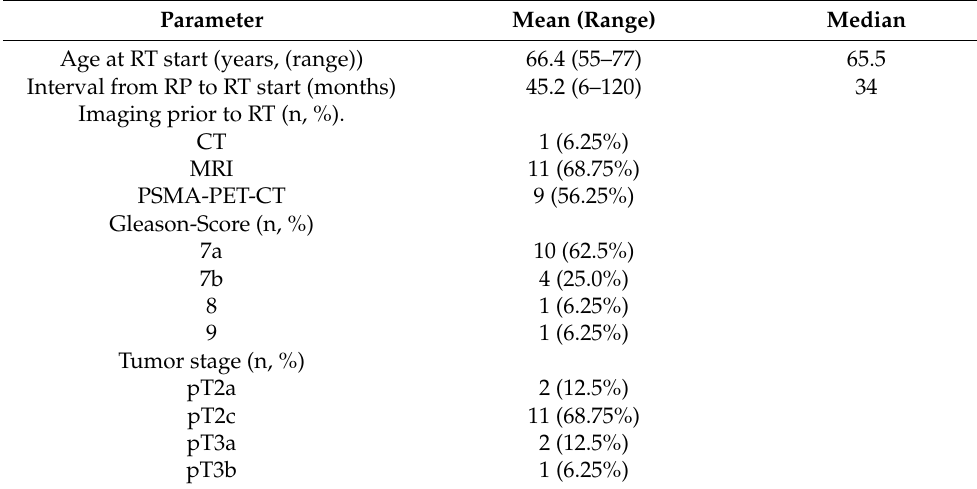
Table 2. Characteristics of the patient